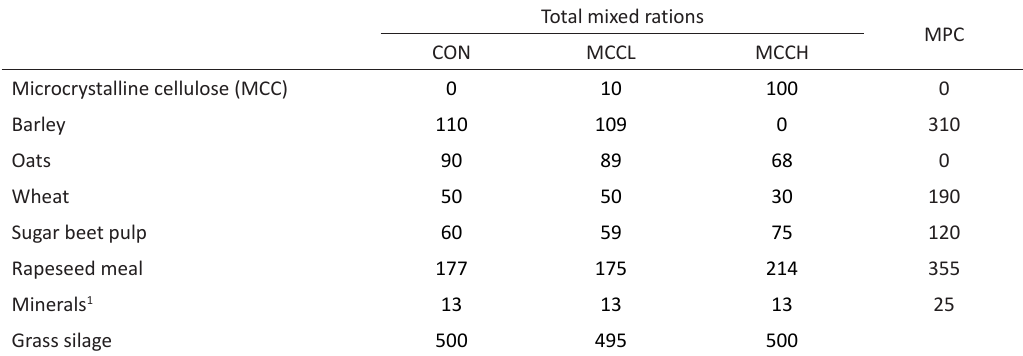
Total mixed rations MPC CON MCCL MCCH